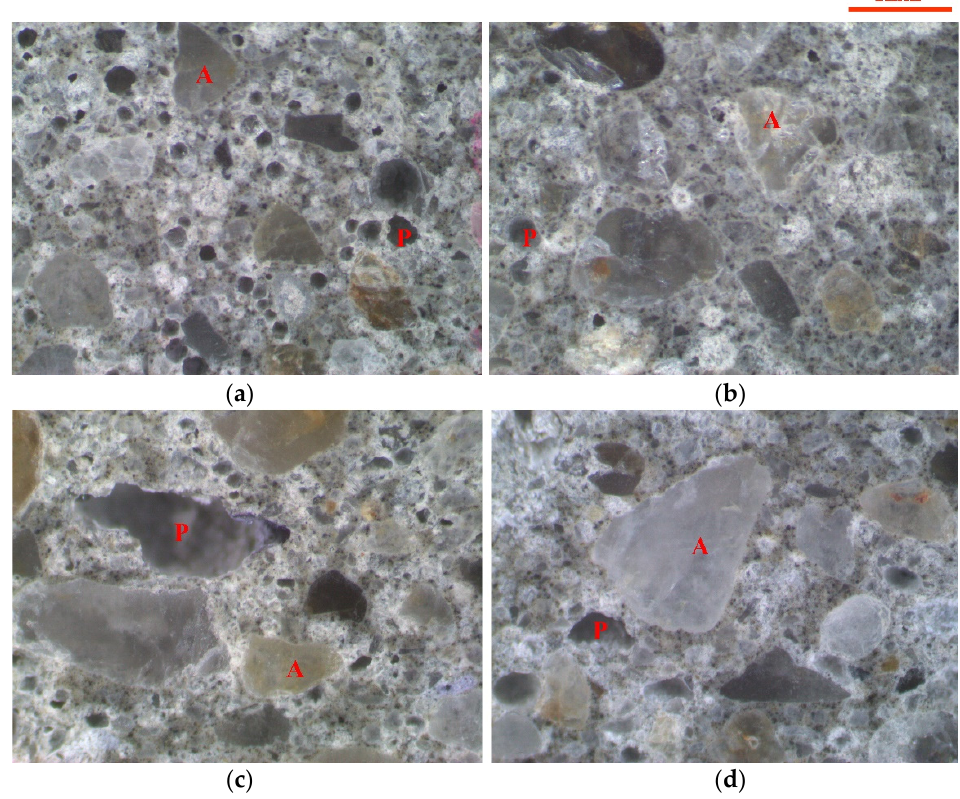
Figure 9. Typical electron microscope images of mould cast mortar and 3D printed mortar. ( a ) Mould cast sample without AFA, ( b ) mould cast sample with 0.05% AFA, ( c ) 3D printed sample without AFA, and ( d ) 3D printed sample with 0.05% AFA, where in the images, A and P represent fine aggregate and the air-void, respectively.